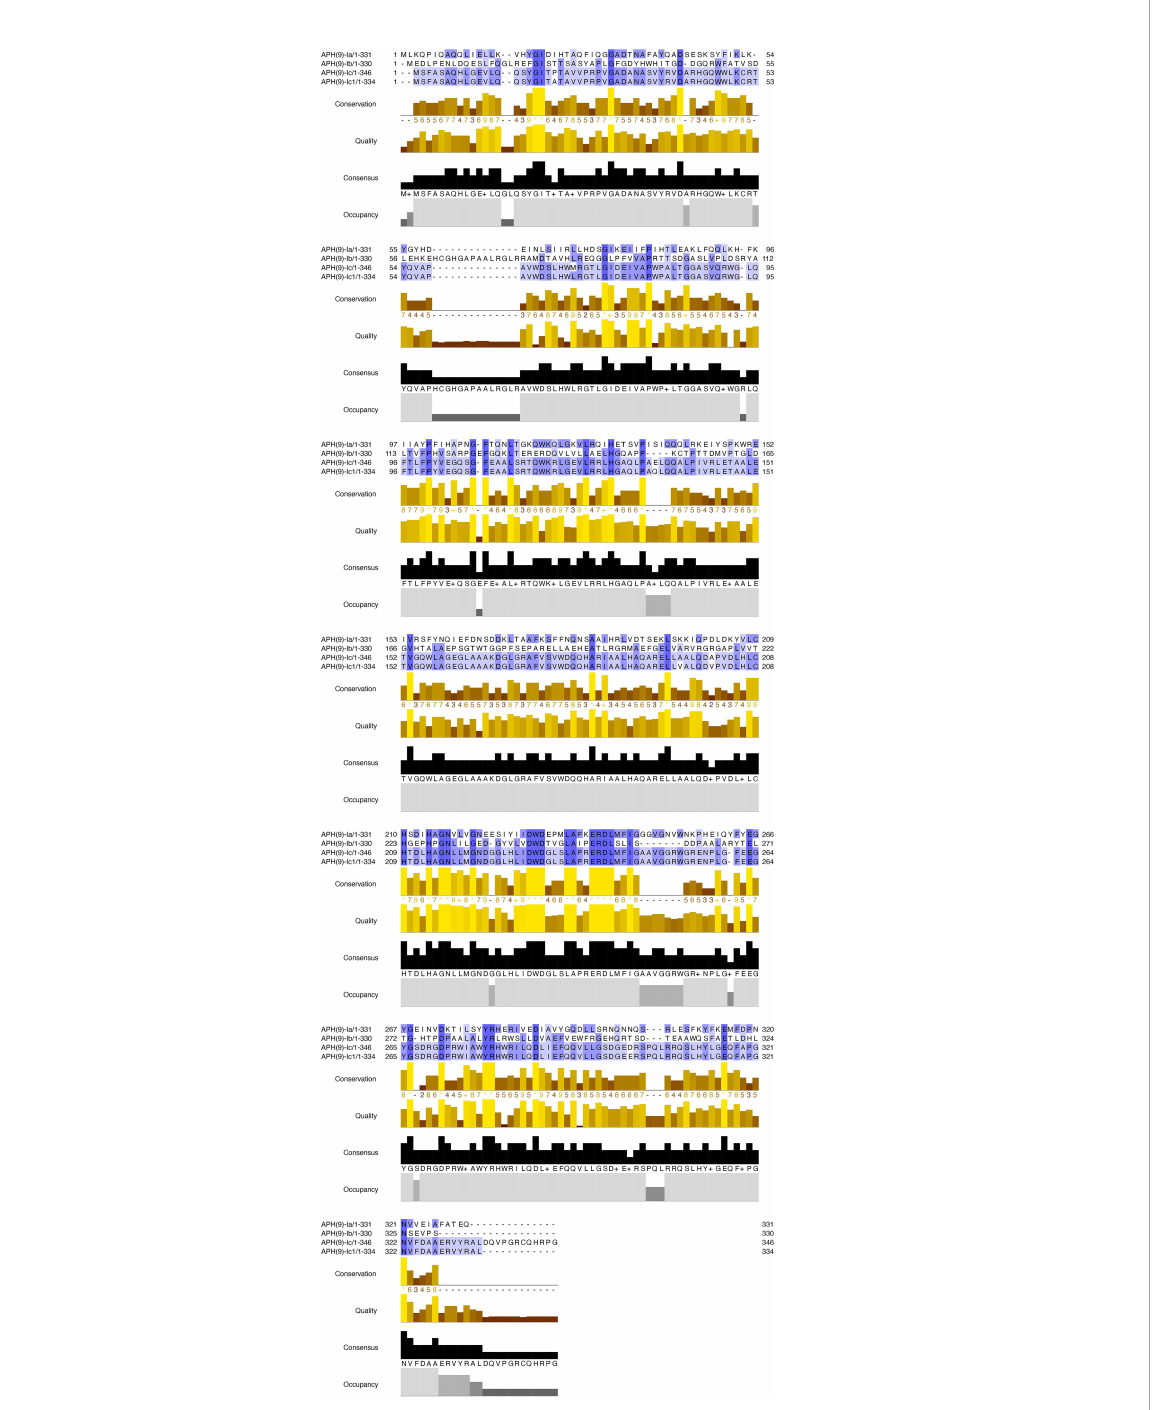
FIGURE 2 Multiple alignment of the amino acid sequences of APH(9)-Ic and other APH(9)-I subgroup proteins. The sequences and their accession numbers are: APH(9)-Ia (AAB58447.1), APH(9)-Ib (AAB66655.1), APH(9)-Ic (USA18493.1) and APH(9)-Ic1 (MCM2524399.1). Conservation, conservation of total alignment less than 25% gap; Quality, alignment based on Blosum62 scores; Consensus, percent of identity; Occupancy, number of aligned positions. The conserved motif sites are grayed. The fi gure was generated using Jalview (Waterhouse et al., 2009) with a ‘ percent identity ’ color